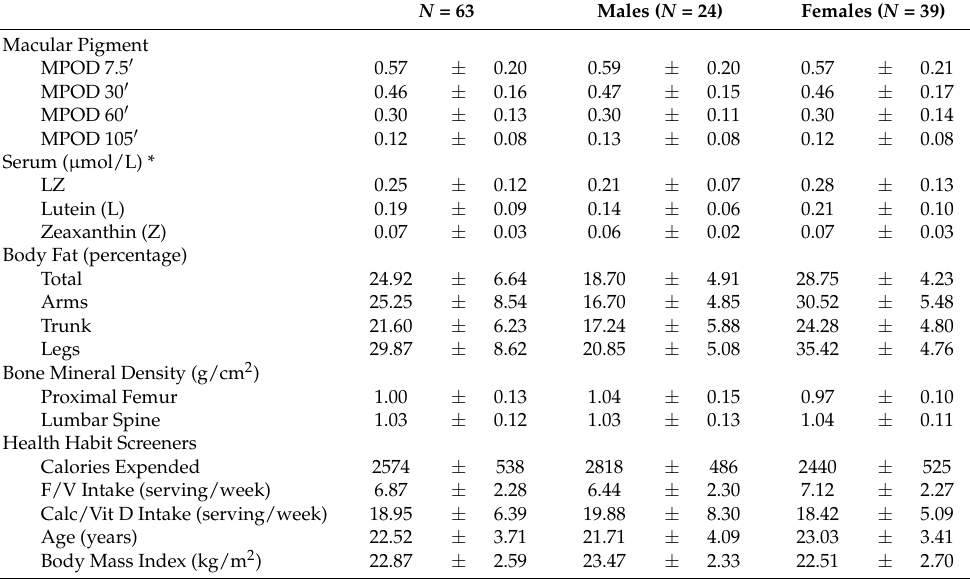
Table 1. Descriptive data (mean ± standard deviation) for all subjects and stratified by sex. N = 63 Males ( N = 24) Females ( N = 39) Macular Pigment MPOD 7.5 (cid:48) 0.57 ±